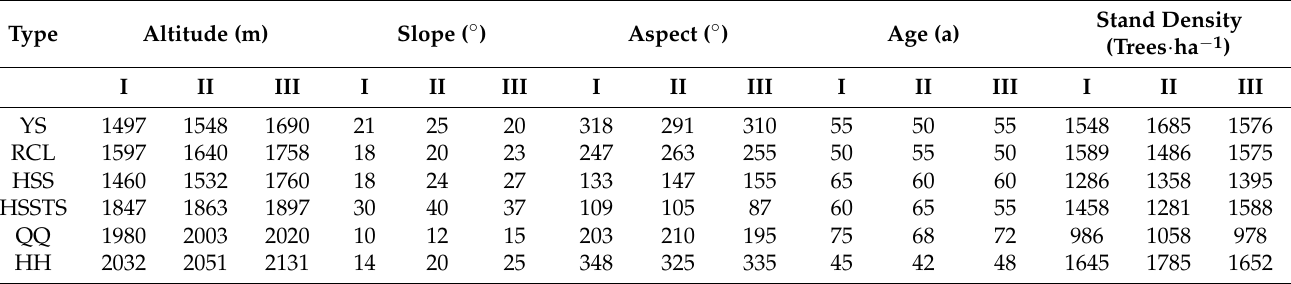
Table 1. Plot characteristics. I, II and III represent the three plots in each forest community, and the density is the number of trees per